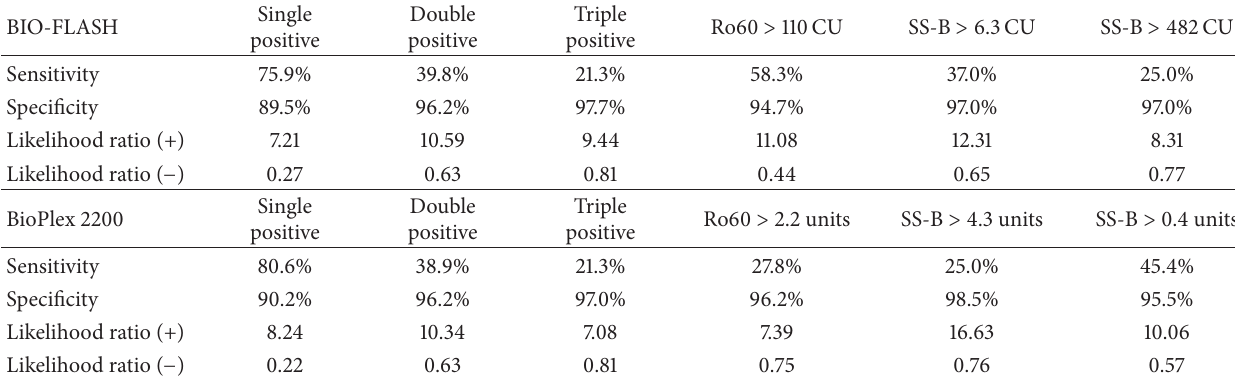
Table 4: Multiple positivity for Ro60, Ro52, and